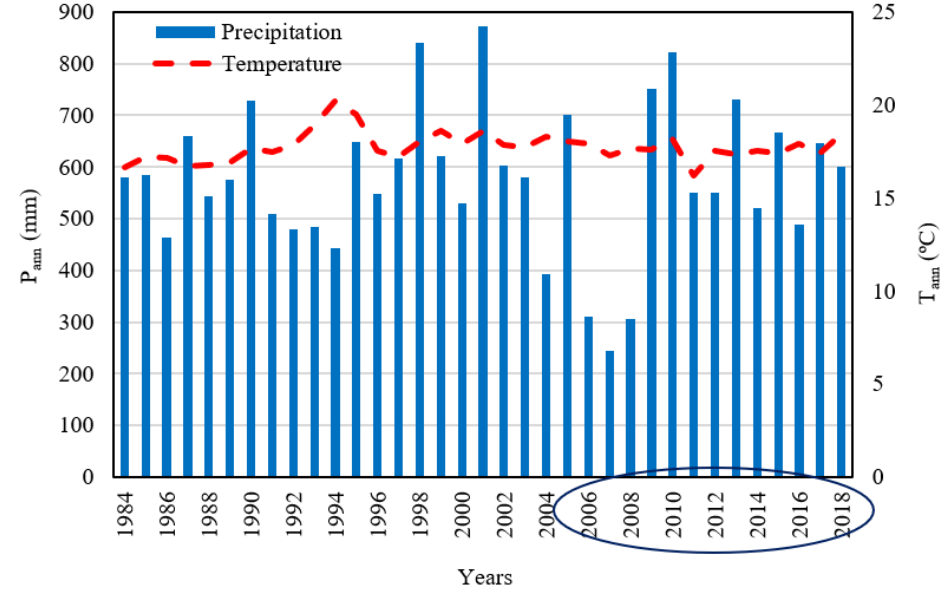
Figure 1. Average annual temperature (T ann ) and annual precipitation (P ann ) for 1984–2018 (TSMS, 2020). The ellipse on the x -axis indicates the 13-year study period.